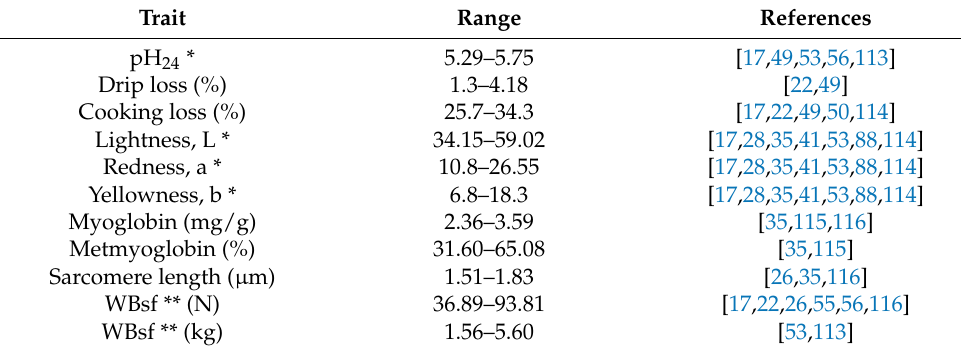
Table 7. Technological traits of river buffalo